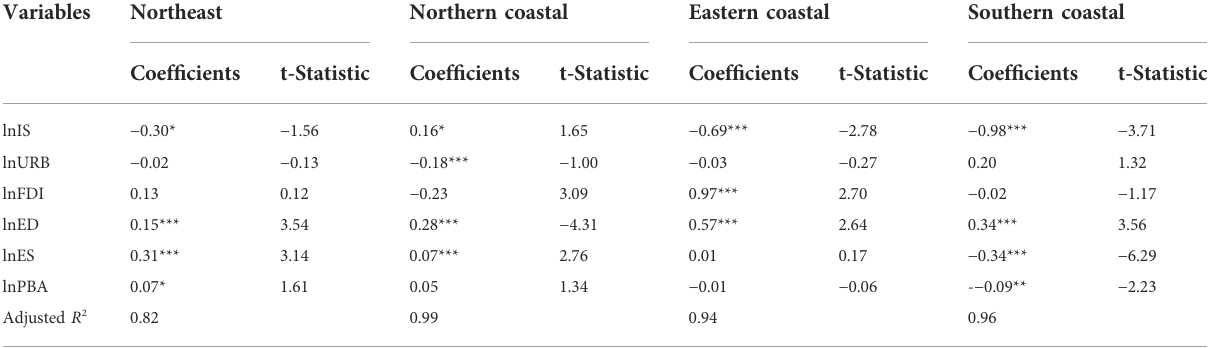
TABLE 6 Fixed effects model regression results (1).